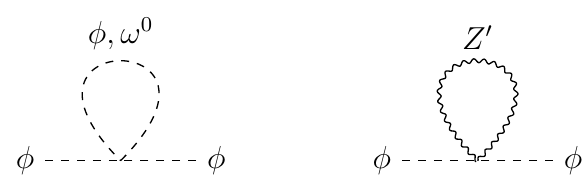
Figure 22 . Tadpole diagrams contributing to the self-energy of (cid:30)